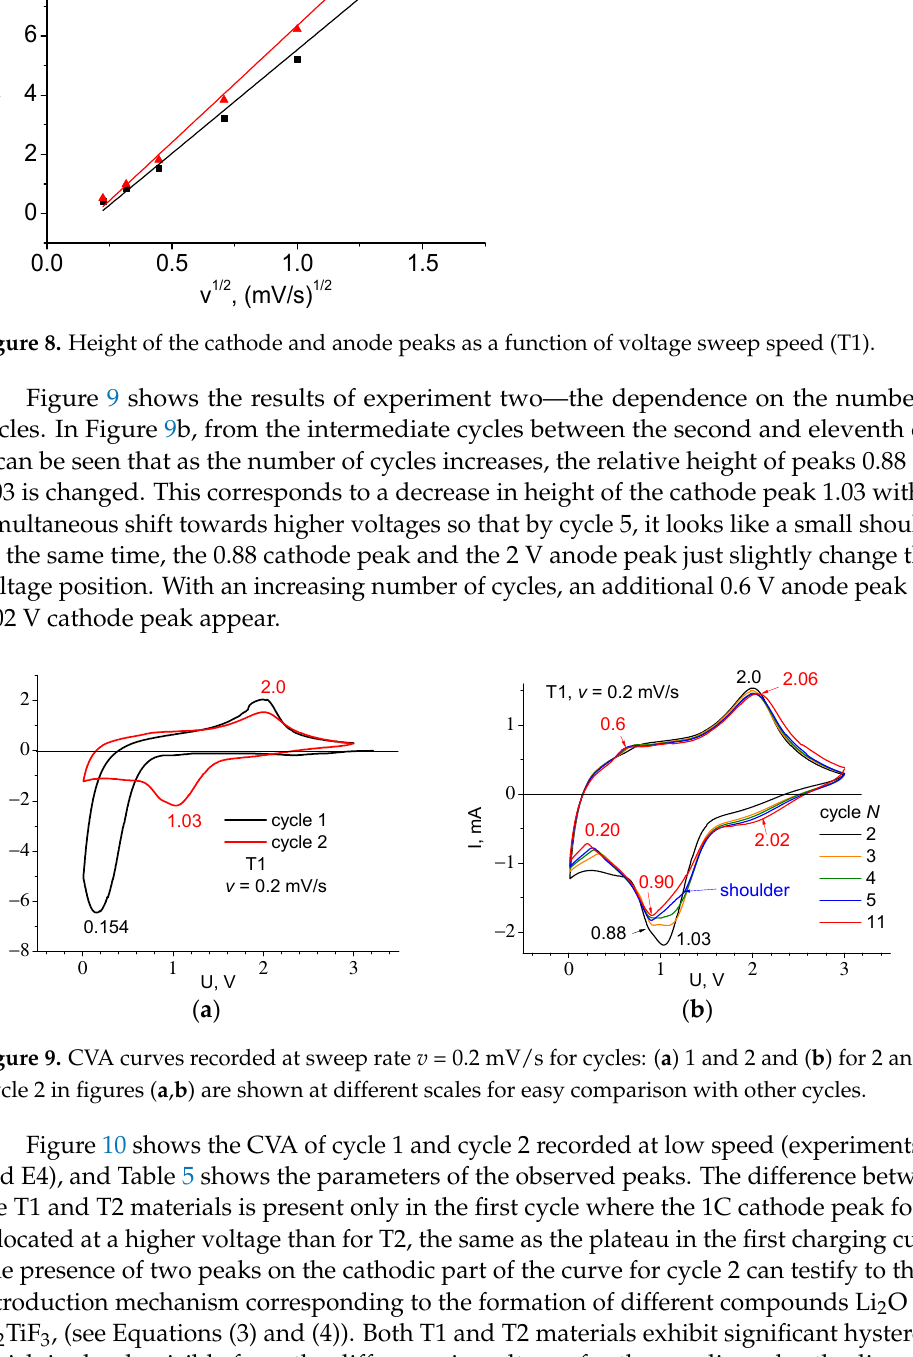
Figure 7. Position of voltage peaks as a function of sweep speed (T1 material): ( a ) cathode C; ( b ) anode A.